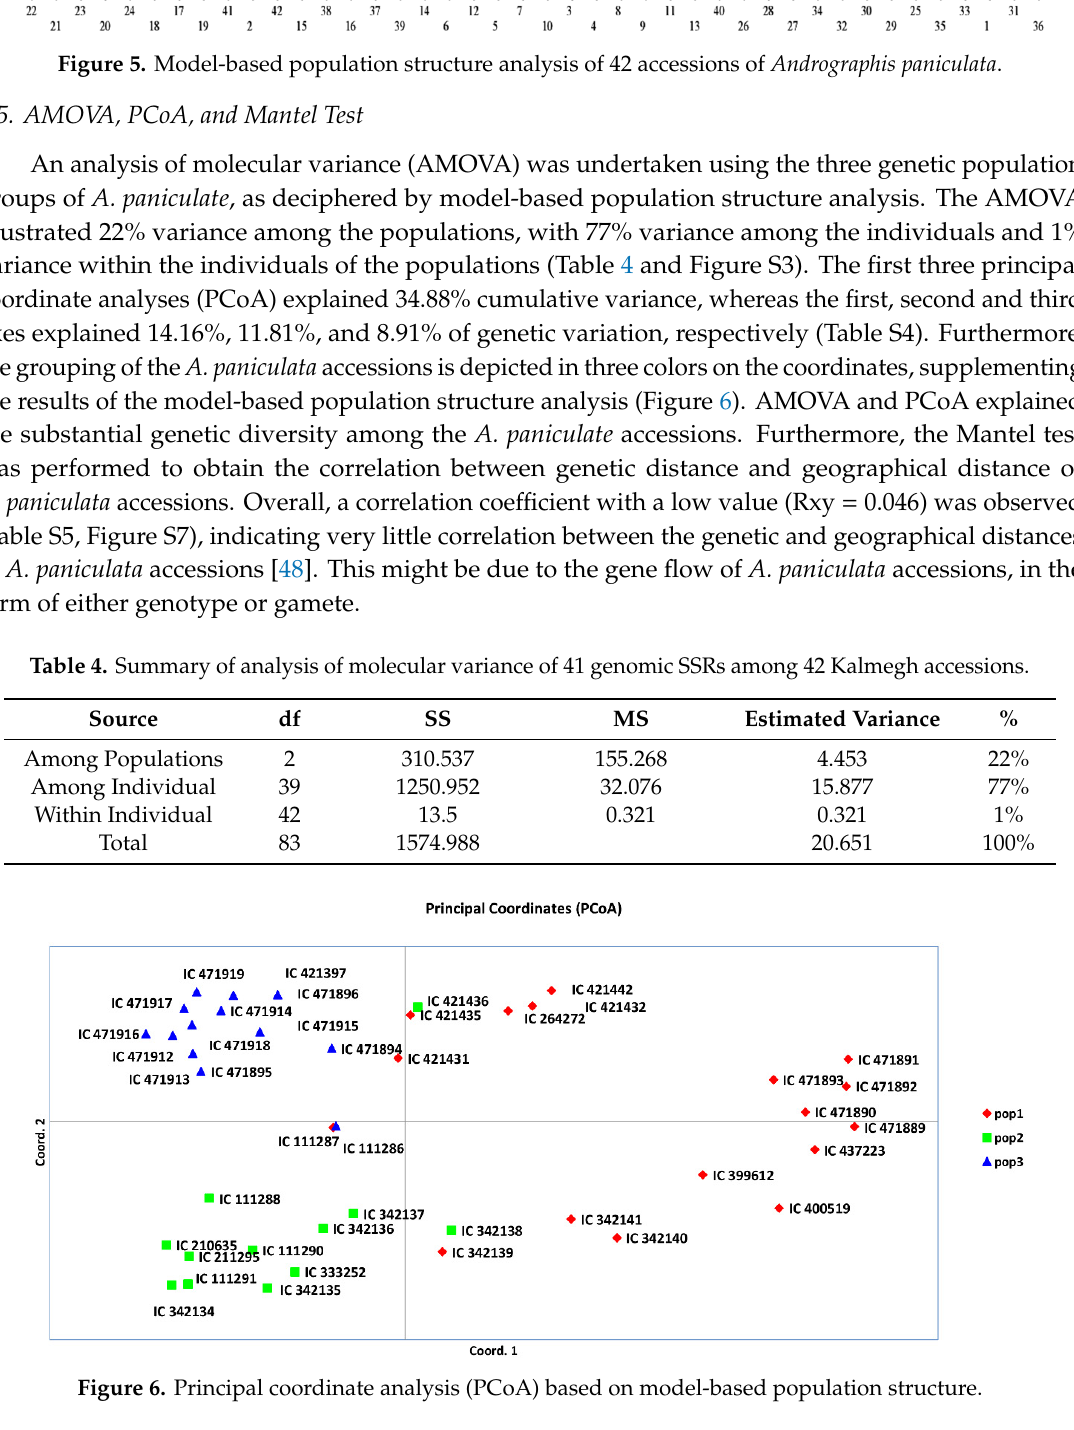
Figure 5. Model-based population structure analysis of 42 accessions of Andrographis paniculata .